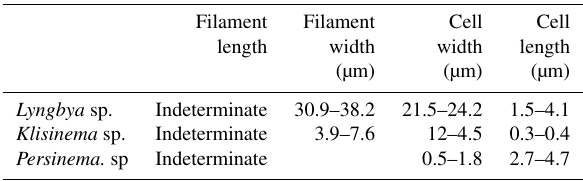
Table 2. Filament and cell dimensions of the proposed cyanobacte- rial